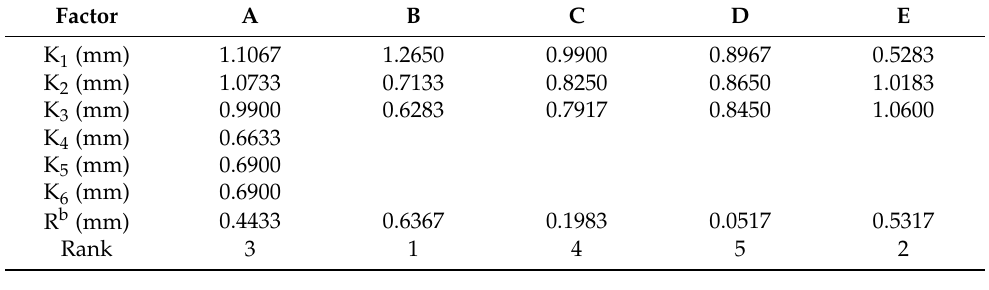
Table 5. Range analysis of the orthogonal experiment (warpage deformation).